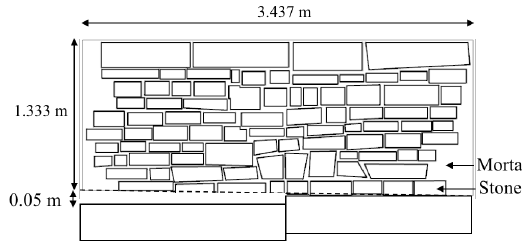
Figure 3. Front view of three-dimensional model showing existing locations of stone and mortar, overall geometry, and settlement